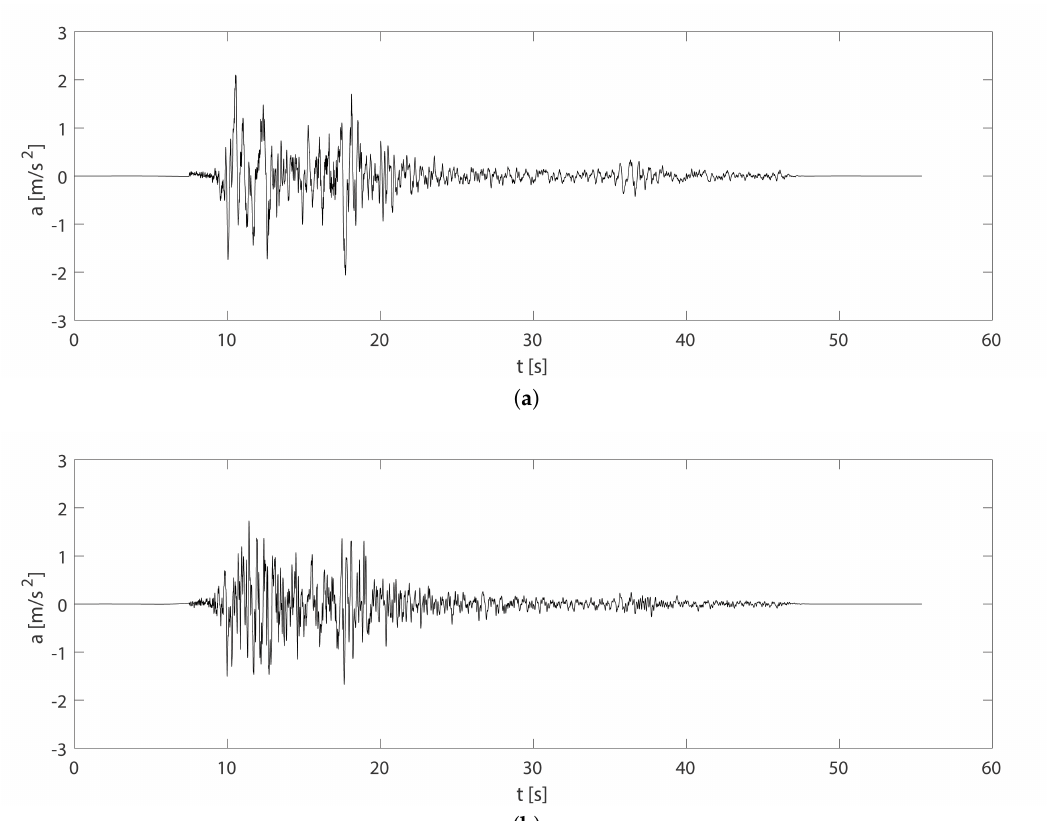
Figure 4. Processed acceleration time-histories of the Montenegro 1979 earthquake. Albatros station records: ( a ) east-west direction. ( b ) north-south direction [27].